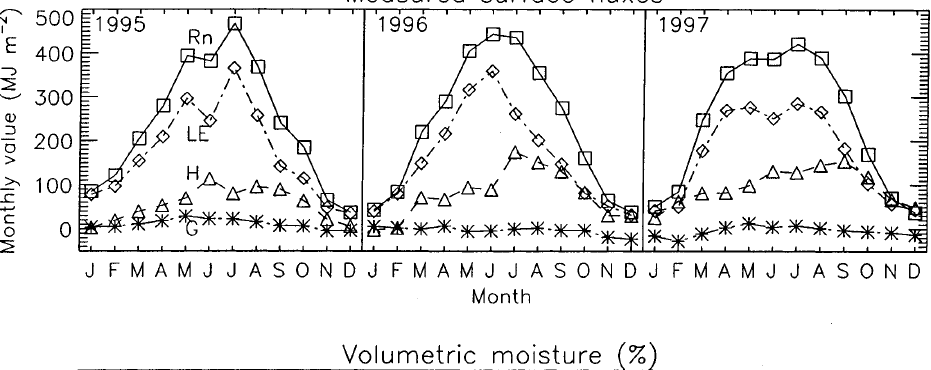
Fig. 4. Monthly sums of the measured fluxes (net radiation, Rn ; sensible heat flux; H ; latent heat flux LE ; and ground heat flux, G over the MUREX fal- low in 1995, 1996, and 1997 (note that LE is estimated by di(cid:128)erence), and a temporal dia- gram of the soil volumetric moisture within the 1.35 m soil layer as measured with a neu- tron probe over the